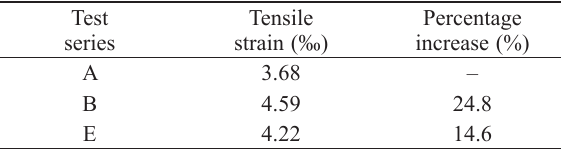
Table 5. Average failure tensile strains in timber